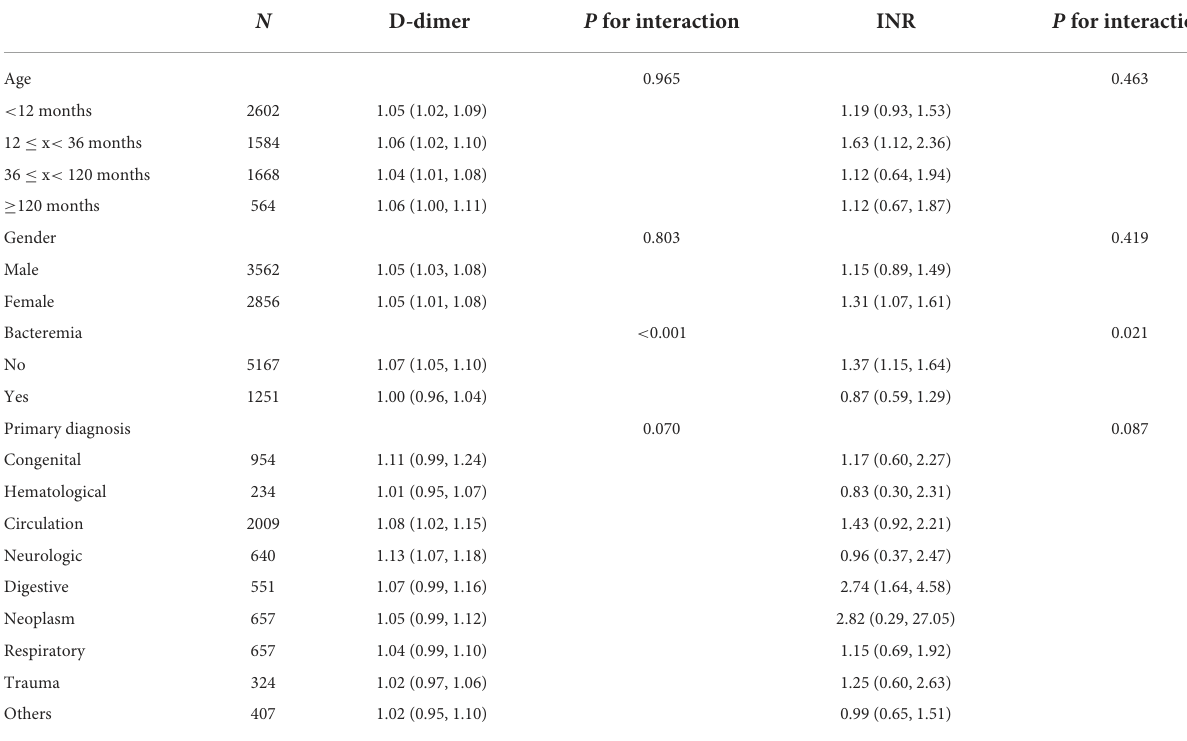
TABLE 4 Subgroup analysis of the association between D-dimer, INR and in-hospital mortality. N D-dimer P for interaction INR P for interaction